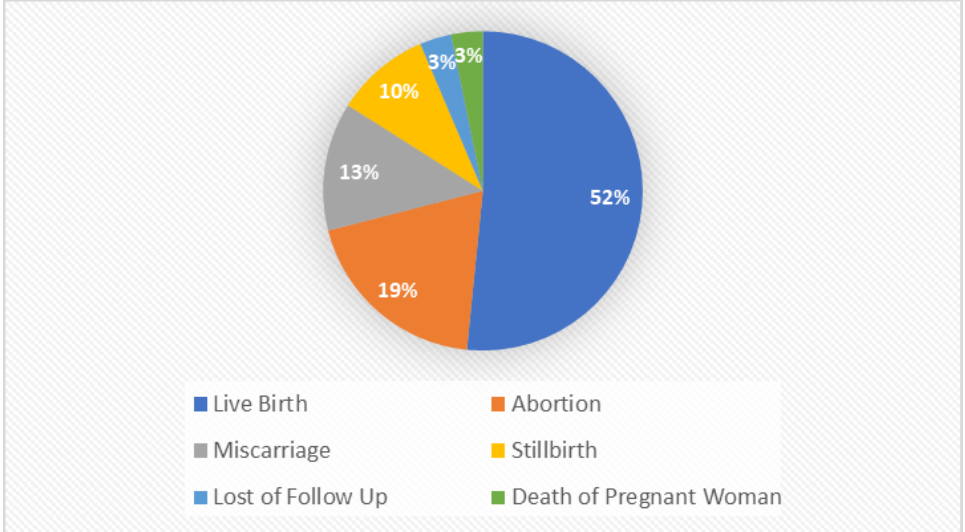
Figure 2. Pregnancy outcomes of the participants.